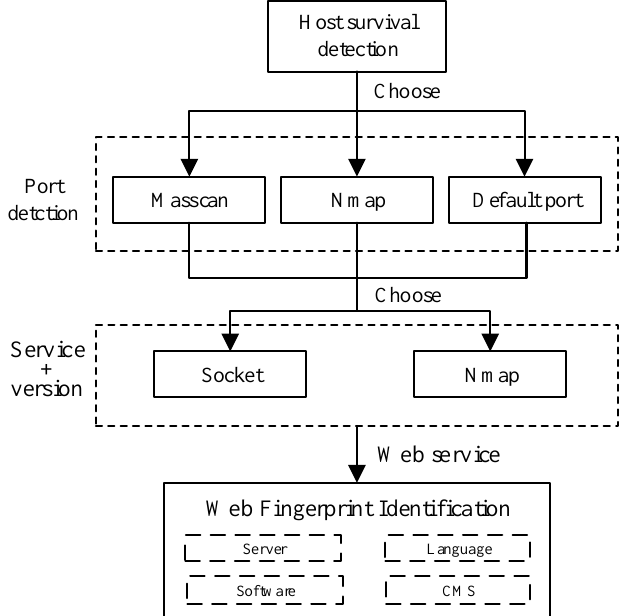
Figure 4. Network asset identification